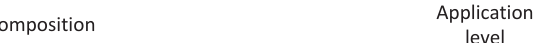
Application level